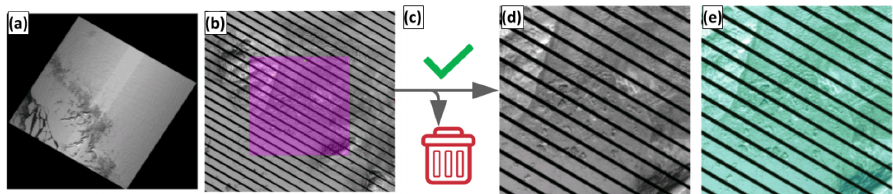
Figure 4. Preprocessing pipeline. (a) First, input the raw Landsat GeoTIFF rasters with < 20% clouds. (b) Next, subset using QGIS/GDAL and the domain shapefile to clip each raster. (c) Then, filter the clouded/NODATA subsets. (d) Now, resize the subsets to 256 × 256px. (e) Finally, enhance contrast and stack with the raw